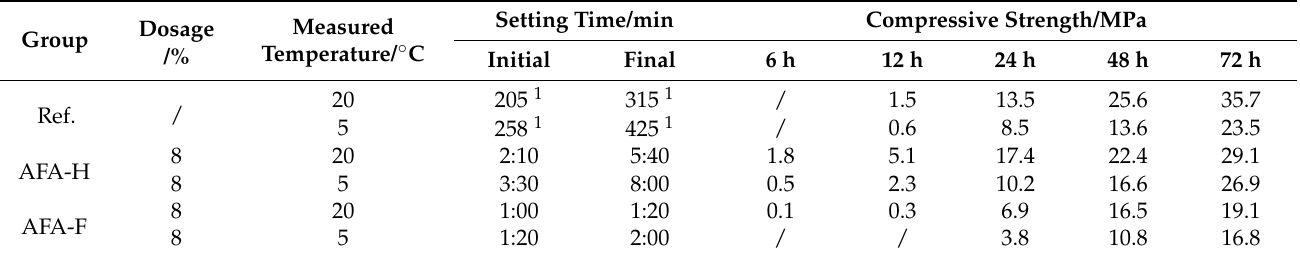
Table 4. Setting time of accelerated cement paste and mortar compressive strength at early